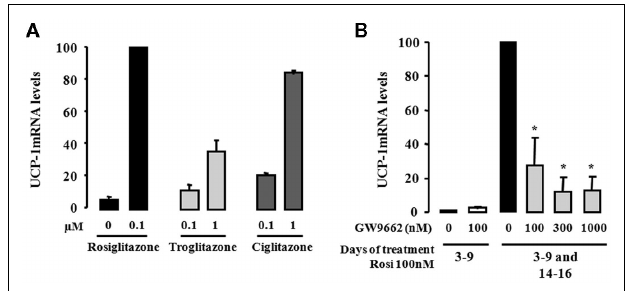
FIGURE 2 |Activation of PPAR γ is involved in the conversion of white to brown adipocytes. hMADS-2 cells were induced to differentiate into white adipocytes in the presence of 100nM rosiglitazone between days 3 and 9, and then treated with various component as indicated between days 14 and 16. (A) Effect of various PPAR γ agonists (Rosiglitazone,Troglitazone, and Ciglitazone) analyzed by quantitative RT-PCR of UCP1 gene expression. (B) Effect of the PPAR γ antagonist GW9662 on UCP1 expression stimulated by rosiglitazone. Results are the mean ± SEM of two independent experiments. Results are expressed by taking as 100% the value obtained at 100nM rosiglitazone. * p < 0.05 vs. cells exposed to 100nM rosiglitazone between days 3–9 and days